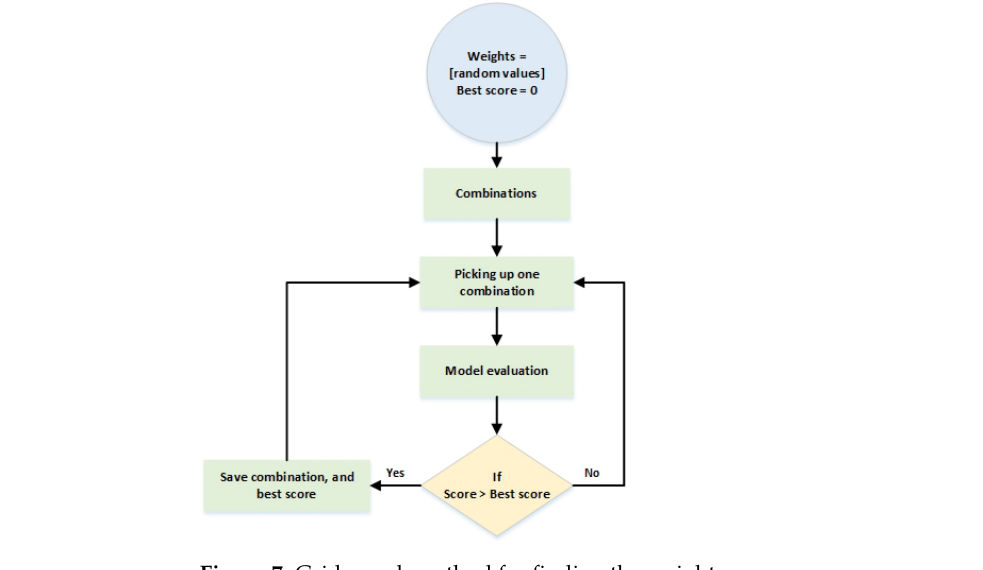
Figure 7. Grid search method for finding the